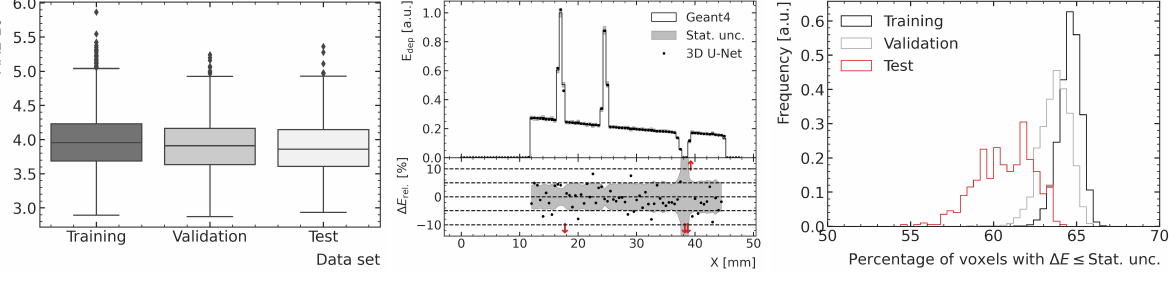
Figure 9. ( a ) Boxplots showing the MAE in the peak region for the training, validation and test datasets. The central line of the each boxplot shows the median of the distribution. The surrounding box is limited by the 25% percentile. The whiskers are shown at the 2.5 × 25% percentile. Data samples further away from the median are represented as outliers. ( b ) Exemplary ML-predicted and MC-simulated energy deposition E dep of the validation data in the peak region. The bottom plot shows the percent relative difference ∆ E rel between ML prediction and MC simulation in terms of energy deposition. Red arrows in the relative energy deviation subplot indicate deviations larger than the shown ranges. ( c ) Fraction of voxels of the ML-predicted energy deposition maps exhibiting a deviation of one standard deviation or less with respect to the mean energy deposition ∆ E calculated with the MC